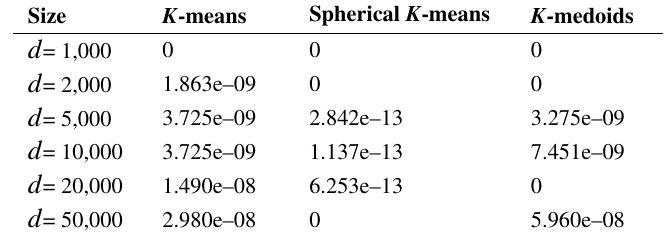
Table 1 The comparison of the objective functions on the artificial data Size